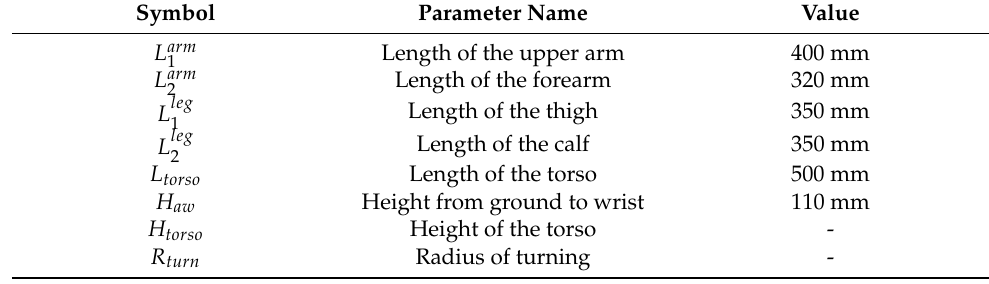
Table 3. Parameters of the crawling motion model.